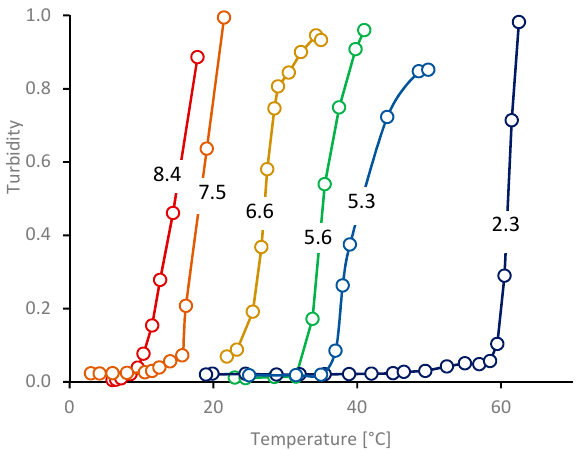
Figure 9. Representative examples of turbidity data vs. temperature, based on diluted NSF in NaCl solutions of the salt concentrations (% w / w ) shown on the graphs.